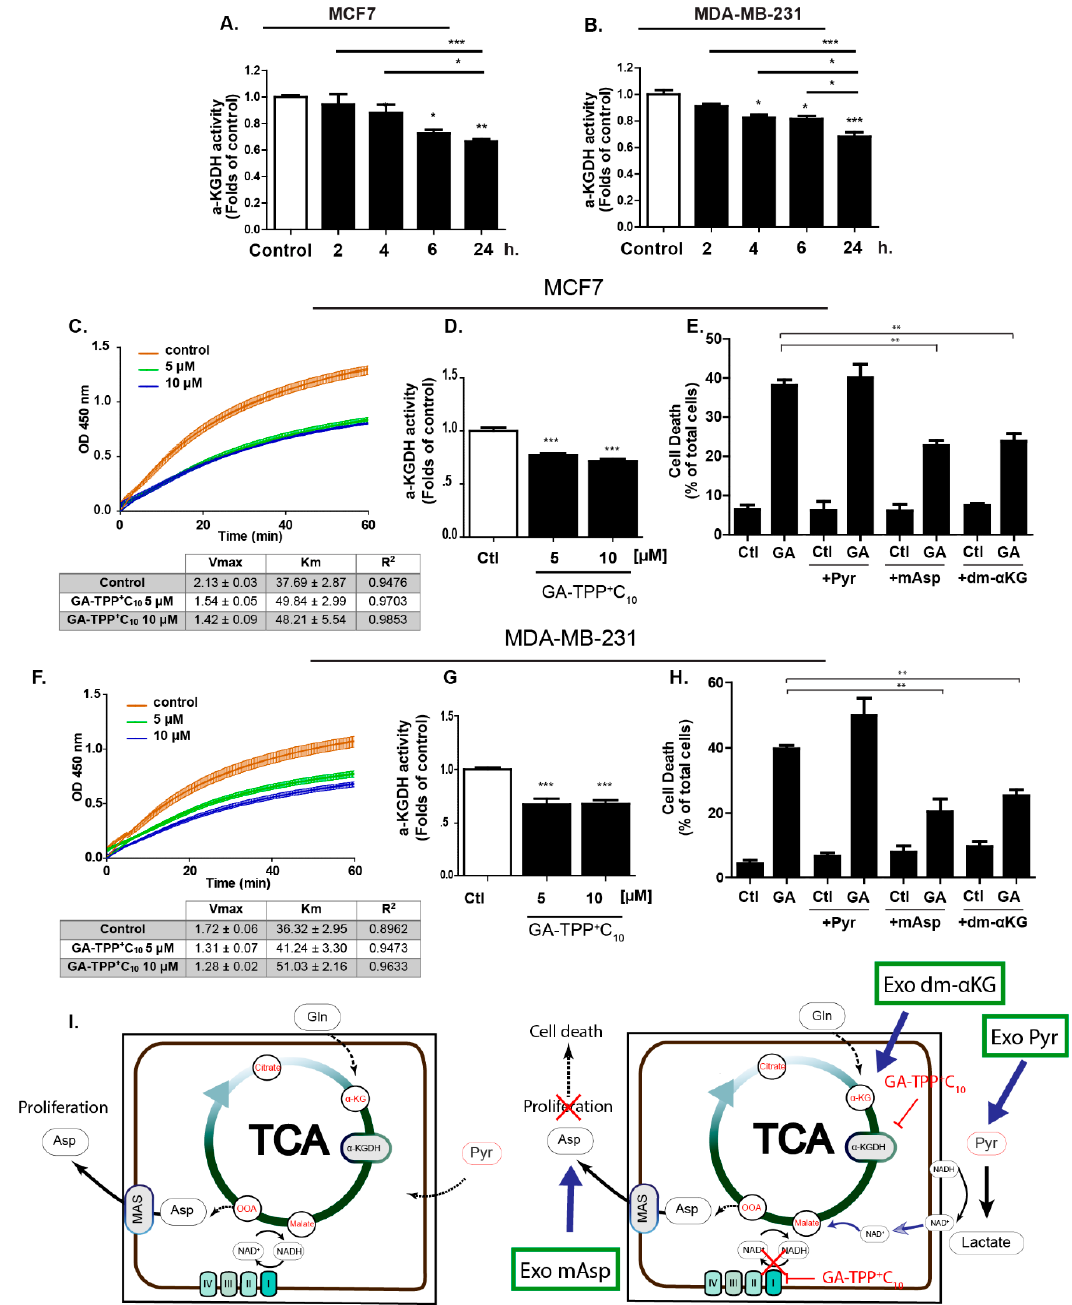
Figure 4. GA-TPP + C 10 decreases alpha-ketoglutarate dehydrogenase ( α -KGDH) activity in BC cells. ( A , B ) Effect of GA-TPP + C 10 (10 µM) on the α -KGDH activity in BC cells at different times of exposure, ( C , D ) Effect of GA-TPP + C 10 (10 µM) on the kinetic parameters of α -KGDH at 24 h of exposure in the MCF7 and ( F , G ) MDA-MB-231 cells; Vmax and km were obtained using Michaelis-Menten fitting. ( E , H ) Rescue of the cytotoxic effect of GA-TPP + C 10 (GA, 10 µM) by L-aspartic acid β -methyl ester (mAsp, 5 mM) and dimethyl α -ketoglutarate (dm-KG, 5 mM) but not pyruvate (Pyr, 5 mM) in BC cells after 48 h. Viability was measured by flow cytometry. ( G ) Rescue scheme for the exogenous addition of the cell-penetrating metabolic intermediates pyruvate (Exo pyr), aspartate (Exo mAsp) and α KG (Exo dm- α KG). Values are expressed as the mean ± SEM of three independent experiments. * p < 0.05, ** p < 0.01, *** p < 0.001 vs. the control (DMSO).